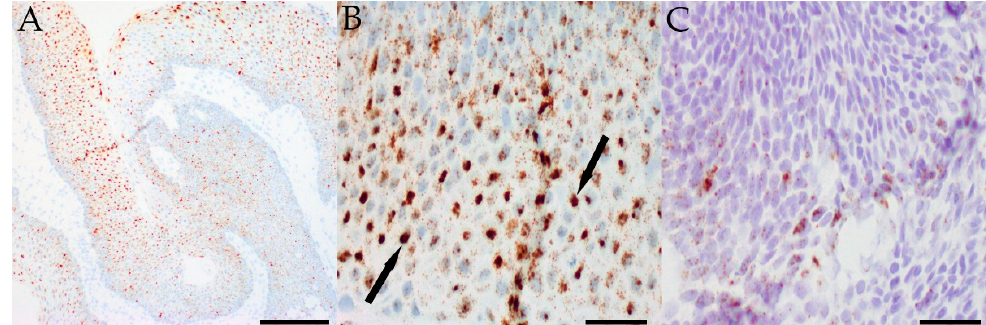
Figure 2. Representative images of in-situ hybridization showing diffuse low-risk HPV positivity in a papilloma from Case 6 using RNA probes ( A ) (scale bar: 100 μ M). At higher magnification, many nuclei are almost completely filled with smaller dot-like foci of staining (arrows) ( B ) (scale bar: 25 μ M). More focal high-risk HPV positivity in a papilloma from Case 16 using DNA probes ( C ) (scale bar: 25 μ M).